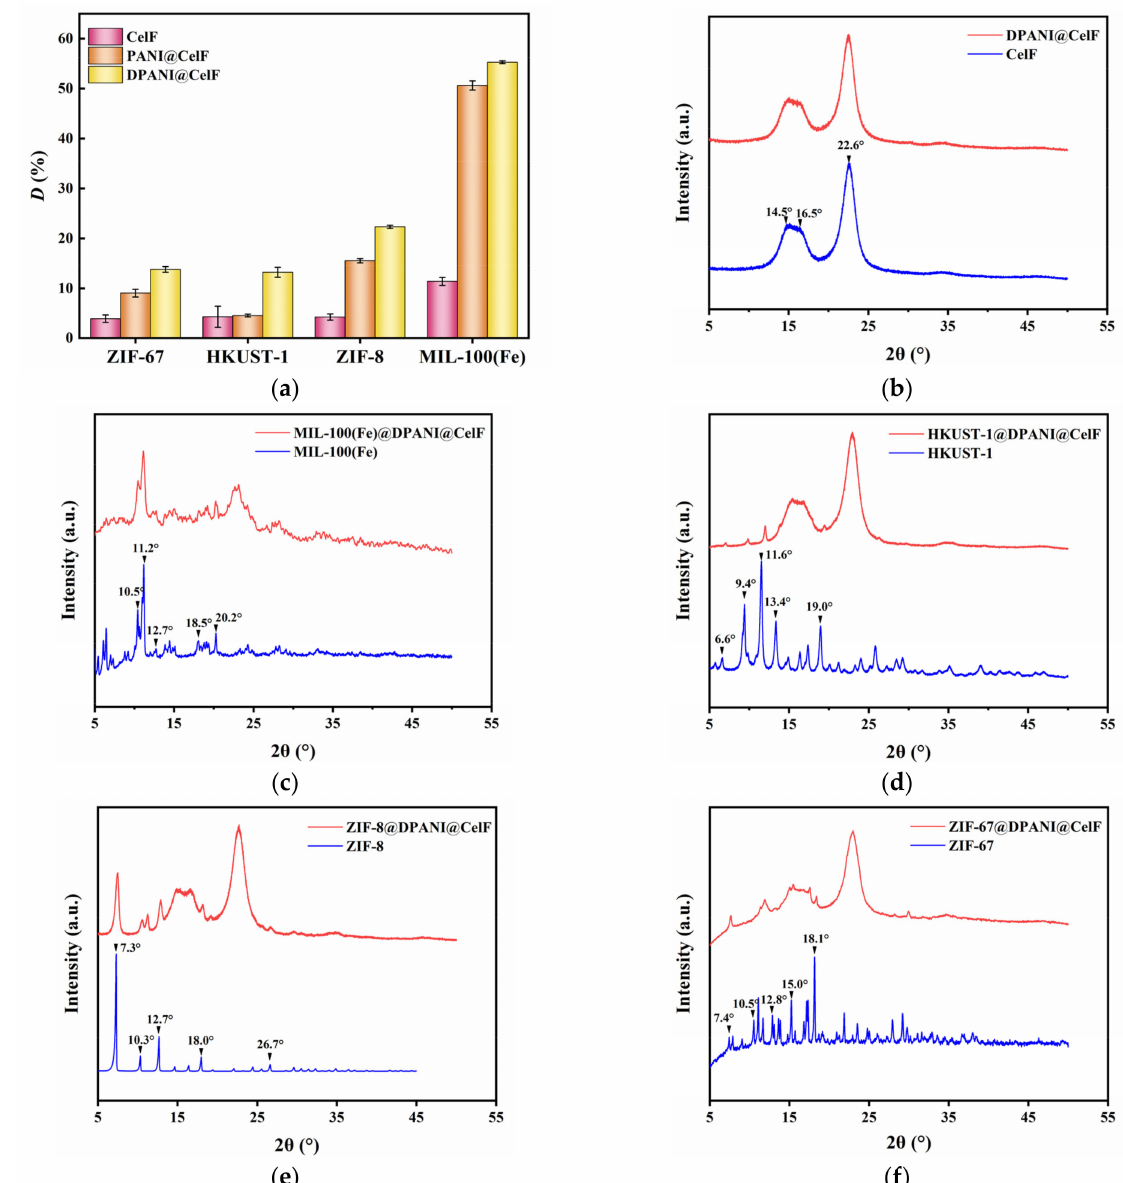
Figure 2. ( a ) Comparison of MOFs’ growth on three CelF substrates; ( b ) XRD patterns of CelF and DPANI@CelF; ( c – f ) XRD patterns of MOFs and their